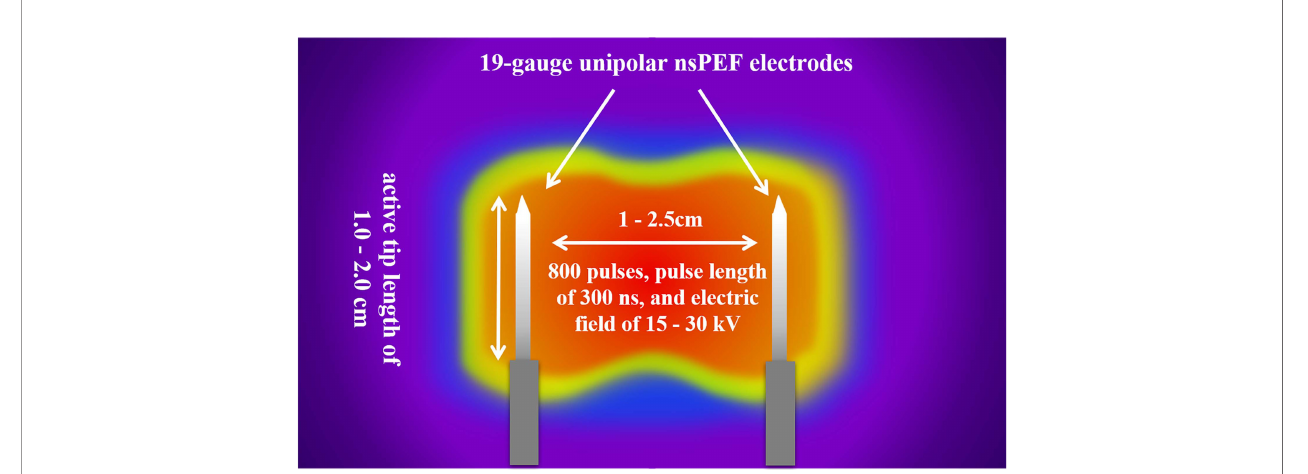
FIGURE 4 | The nsPEF procedure strategy. Depending on the individual tumor size and shape, 2 to 6 19-gauge unipolar electrodes with an appropriate active tip length of 1.0 to 2.0 cm will be placed 1.0 to 2.5 cm apart using ultrasound guidance. The nsPEF will be conducted with 800 pulses of 300ns duration, and an electric fi eld of 15 to 30 kV. nsPEF, nanosecond pulsed electric fi eld.